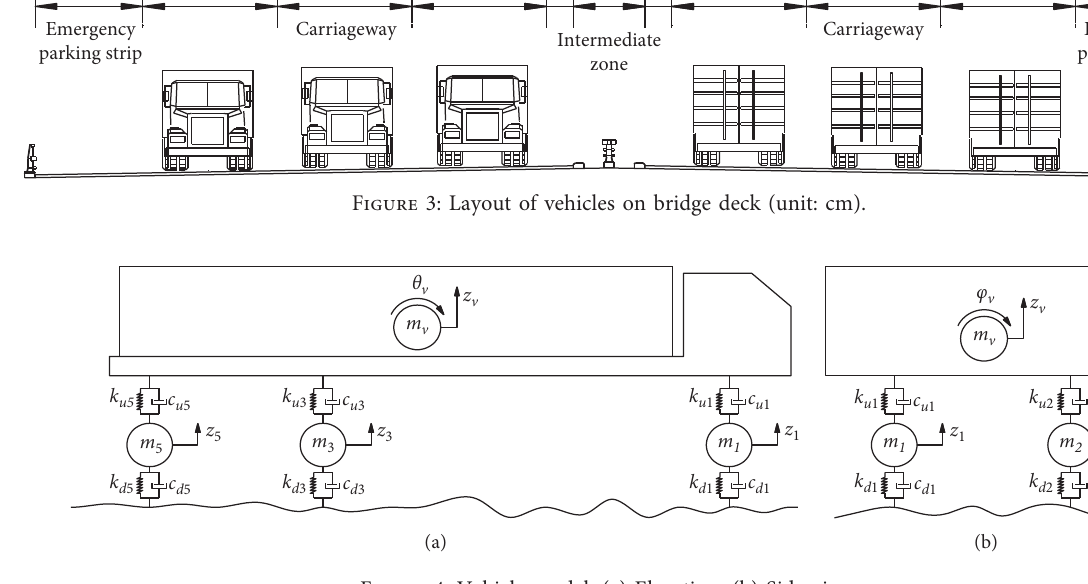
Figure 4: Vehicle model. (a) Elevation. (b) Side view.